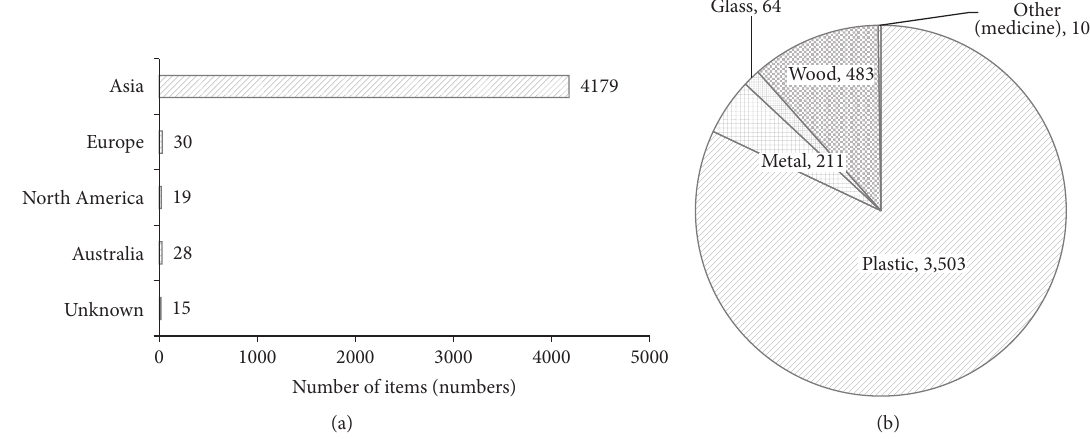
Figure 2: Total labeled items (number, items ) found at beach surveys according to (a) continents and (b) debris